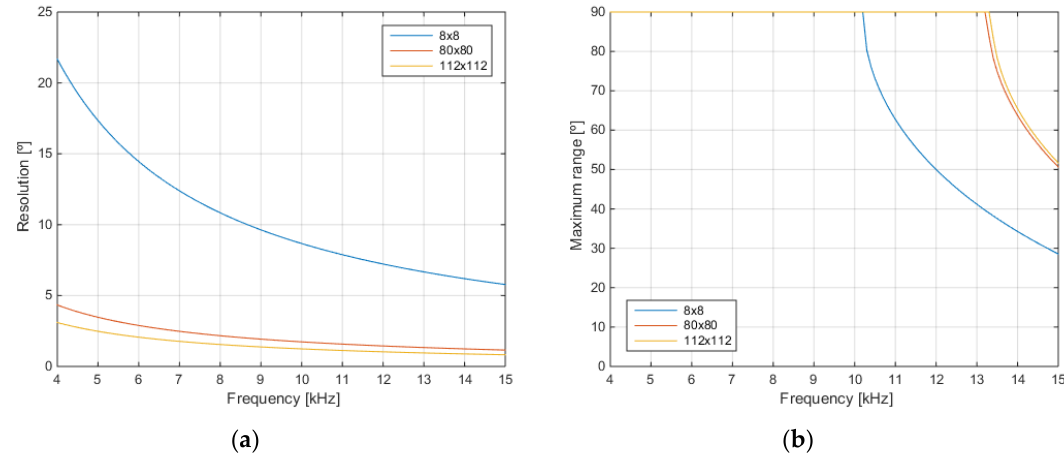
Figure 8. ( a ) Resolution; and ( b ) maximum range vs. frequency for physical array 8 × 8 and 80 × 80 and 112 × 112 virtual arrays.